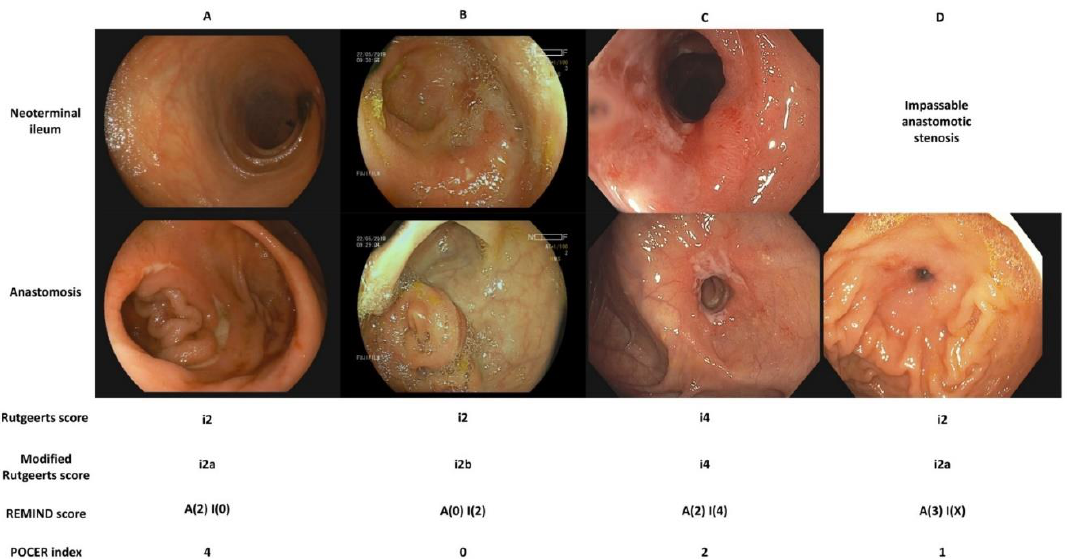
Figure 1. Comparison of endoscopic indices for the assessment of postoperative Crohn’s disease. ( A ). The neoterminal ileum is free of ulceration, two ulcers, one of them deeper than 2 mm, are present at the anastomosis and cover more than 50% of the circumference. ( B ). There are more than five aphthous ulcers with normal intervening mucosa in the neoterminal ileum. The anastomosis is free of ulceration. ( C ). The neoterminal ileum is diffusely inflamed with large ulcers. The anastomosis is superficially ulcerated along more than 50% of its circumference. ( D ). The anastomosis is impassable due to stenosis. A superficial ulcer covers less than 25% of its circumference. Note that an anastomotic stenosis should be scored as i2 on the Rutgeerts score and i2a on its modified version. Only a stenosis in the neoterminal ileum should be scored as i4. Table 1. Endoscopic indices used for the assessment of postoperative Crohn’s